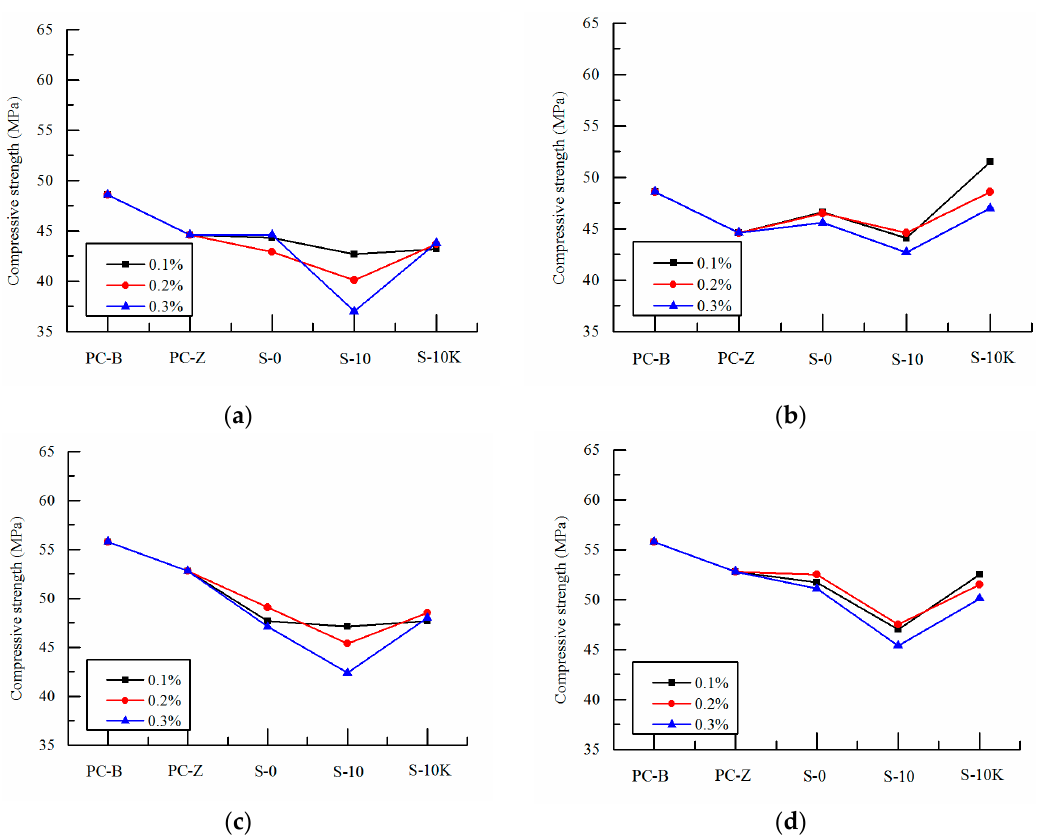
Figure 3. Effects of SAP on compressive strength of concrete at early ages: ( a ) 7 days SAP-a; ( b ) 7 days SAP-b; ( c ) 14 days SAP-a; ( d ) 14 days SAP-b, S-10 and S-10K are pre-absorbed, and S-0 is non-absorbed.